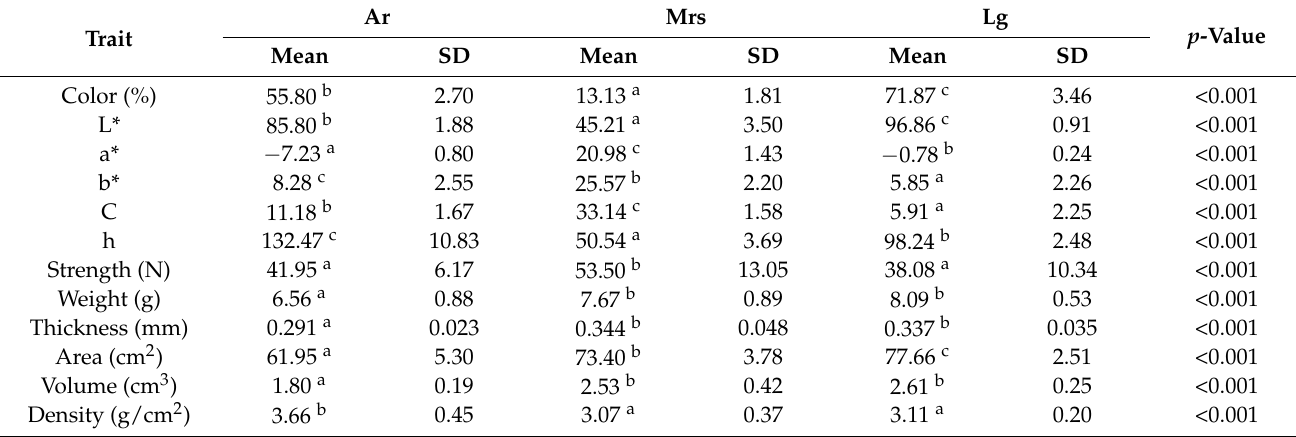
Density (g/cm 2 ) 3.66 b <0.001